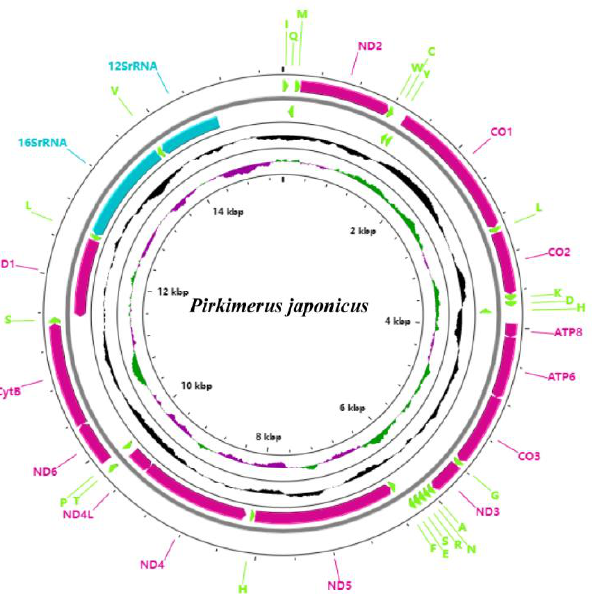
Figure 2. Structure of the mitogenomes of Pirkimeru japonicus . Arrows indicate the orientation of gene transcription. Ticks in the inner circle indicate sequence length.